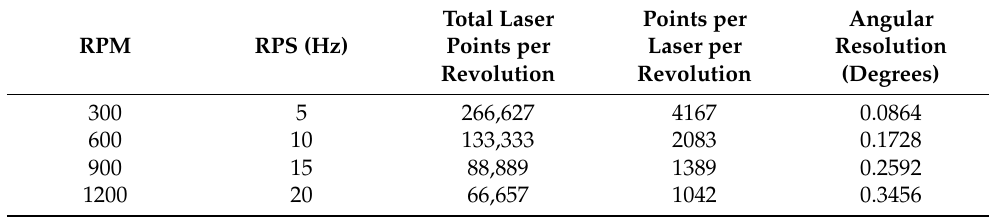
Table 1. HDL-64 rotation rate and angular resolution comparison table [35]. RPM RPS (Hz)